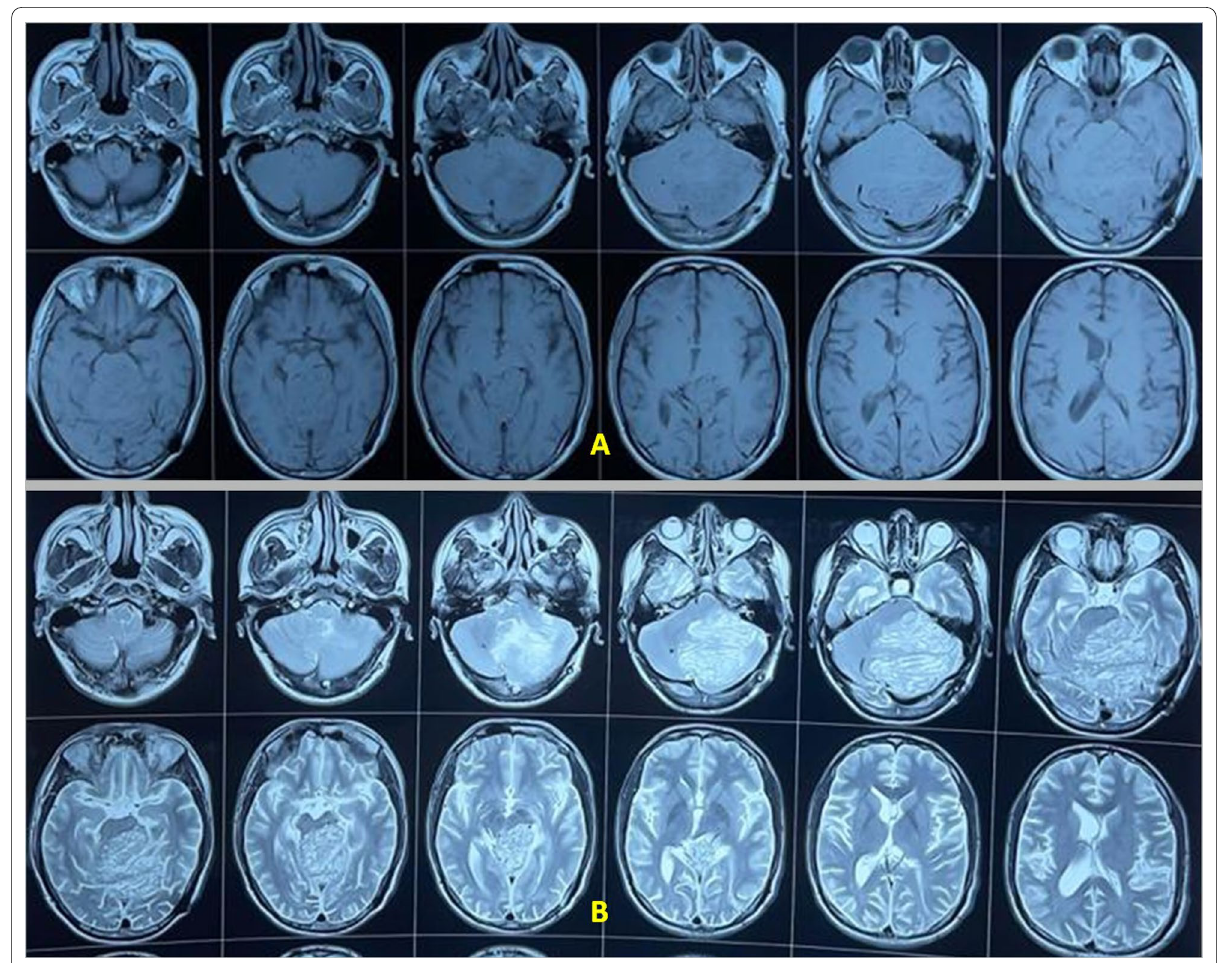
Fig. 2 Preoperative MRI scan. a T1WI shows hypo-intense lesion involving the tentorial and petrosal areas of the cerebellum, upper 2/3rd of the vermis, with an indentation on the brain stem. b T2WI shows a hyperintense lesion with alternating hypo-intense bands giving the characteristic "tiger stripe" appearance. There is thinned-out cerebellar parenchyma overlying the lesion. There is no perilesional edema